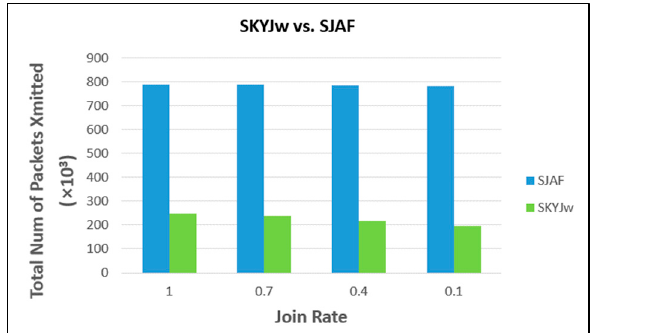
( b ) Figure 13. Comparison between SKYJw and SJAF ( a ) as the size of a region varies ( b ) when the size